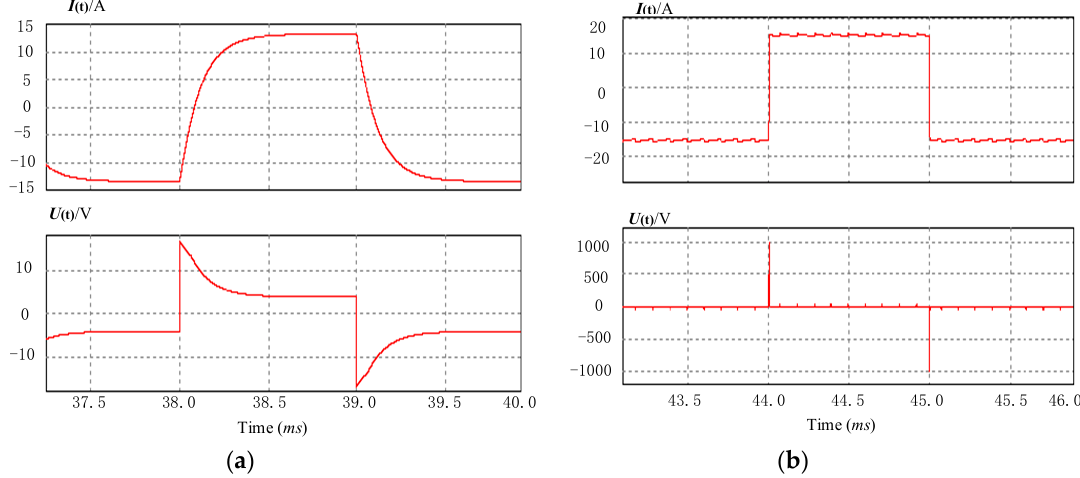
Figure 6. Waveforms of the output current and voltage, 500 Hz. ( a ) Traditional full-bridge circuit; ( b ) Constant current and voltage clamping control circuit.